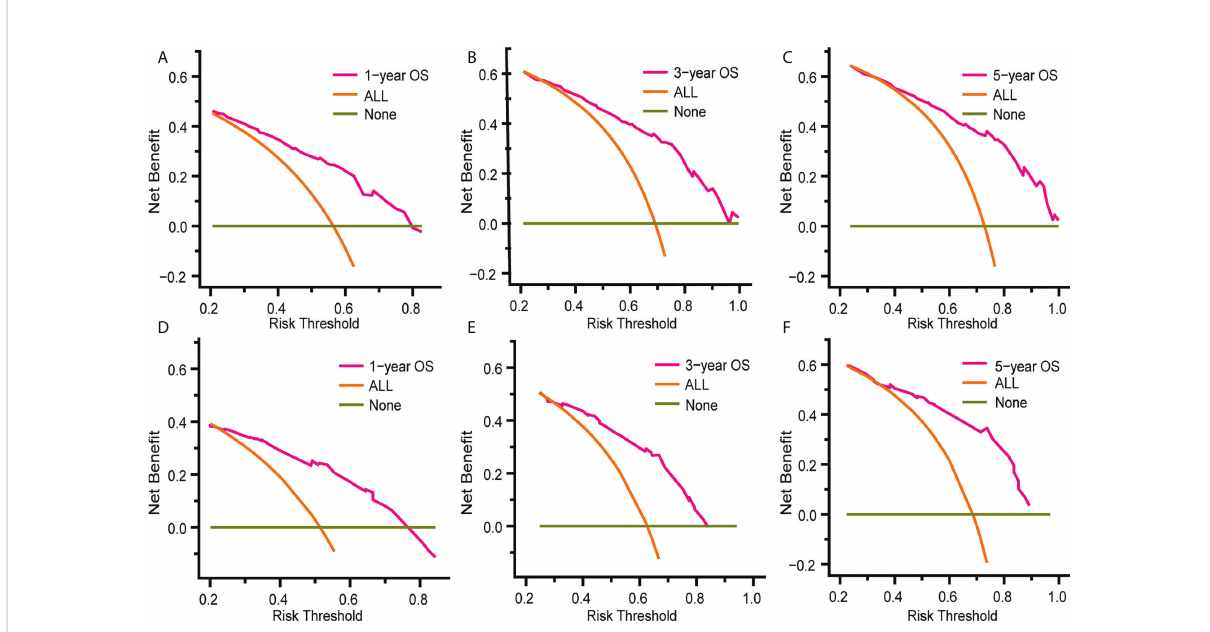
FIGURE 6 Decision curve analysis (DCA) of the nomogram for predicting 1-, 3- and 5- year OS rates in patients with eMS in the training cohort (A – C) and the validation cohort (D – F) . DCA was used to evaluate the clinical utility of the nomogram by calculating the net bene fi ts of the model under different thresholds. The x-axis represents threshold probability, and the y-axis represents net bene fi t. The horizontal dark green line represents no deaths occurring, and the orange line represents all patients died. The pink line represents our nomogram model and when it is maintained above the dark green and orange line mentioned above, the net bene fi t value of the model is positive, which implies that our model has good clinical utility.